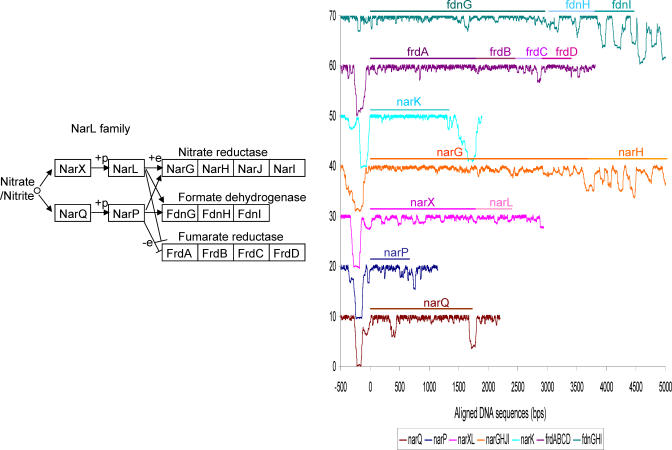
SIDD Profiles of the Genomic Regions Containing Genes (Openons) in Nitrogen Metabolism Regulatory PathwayThe left panel shows a diagram for nitrogen metabolism regulatory pathway, redrawn with permission from [56]. The right panel shows the SIDD profiles for the operons encoding the genes for the proteins in the nitrogen metabolism regulatory pathway. These profiles are aligned at their translation start sites.